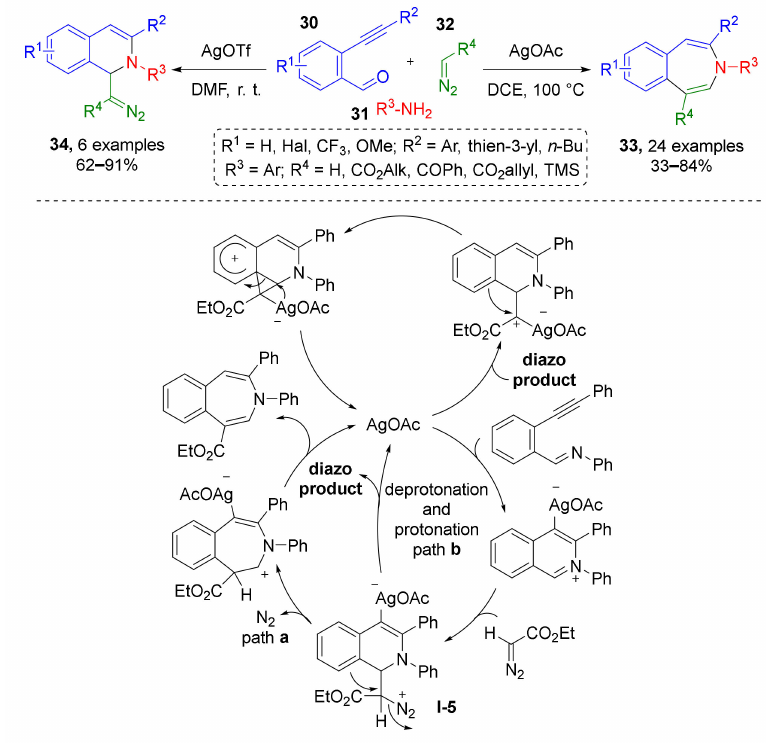
Scheme 9. Ag(I)-catalyzed synthesis of 3-benzazepines and diazo-containing dihydroisoquinolines. The same group later described a similar three-component protocol where iminium was generated via condensation of NH-tetrahydroisoquinoline 34 and aromatic aldehydes 35 followed by silver-catalyzed (AgOAc) nucleophilic addition of terminal diazo esters or amides 36 (Scheme 10) [22]. Obtained tetrahydroisoquinolinic diazo compounds 37 were isolated and applied in rhodium-catalyzed synthesis of dihydrobenzazepines 38 and 38 (cid:48) . The latter were formed as isomeric mixtures due to the following two types of transformations of the Rh-carbenoid—classic 1,2-aryl- or unexpected 1,2- N migration.